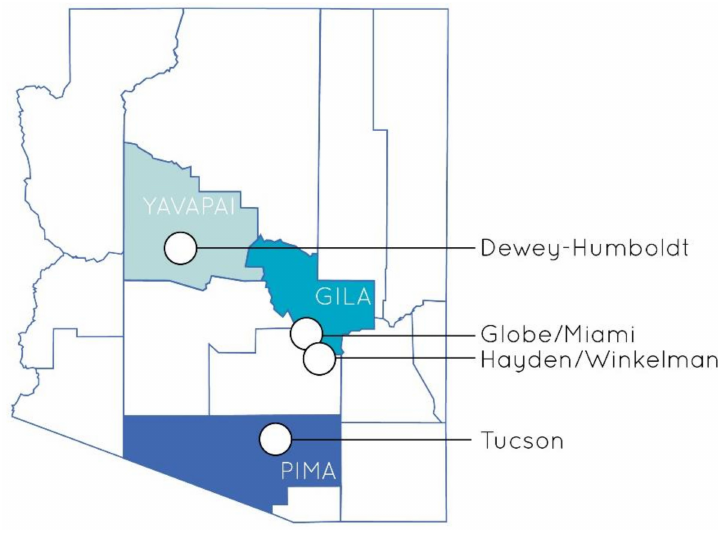
Figure 2. Partnering community locations in Arizona, USA.